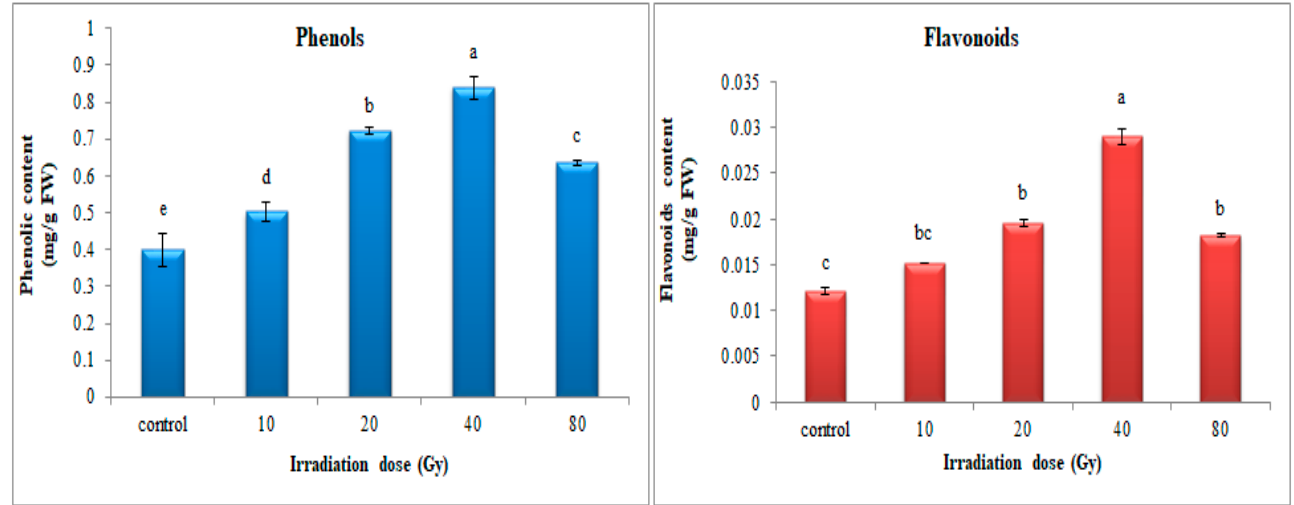
Figure 6. Phenolic and flavonoids content (mg/g FW) of red radish roots affected by different doses of gamma-rays. Findings are means ± standard deviations (n = 3). Different letters point to significant variations at p ≤ 0.05; bars indicated standard deviations.